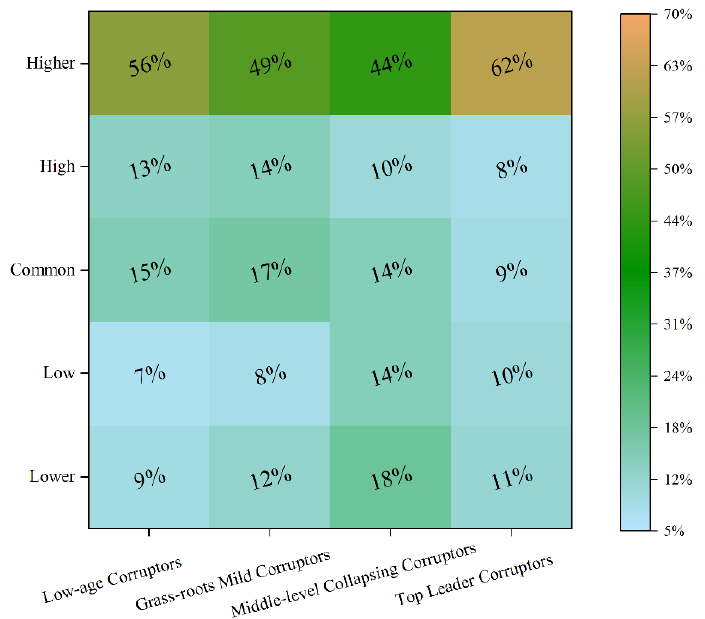
Figure 5. Heat map of four types of corruption actors in different corruption regions.